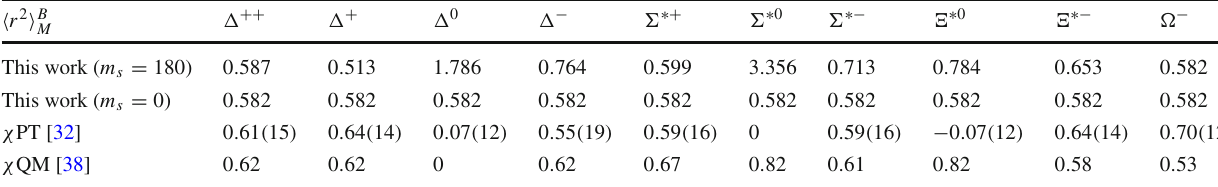
Table 3 Magnetic radii of the baryon decuplet in comparison with those of the chiral quark model [38], χ PT [32]